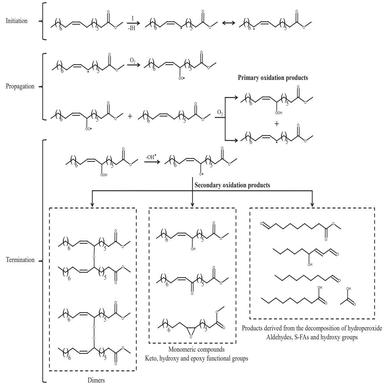
Mechanism for the auto-oxidation of oleic acid methyl ester to the formation of its primary and secondary oxidation products.